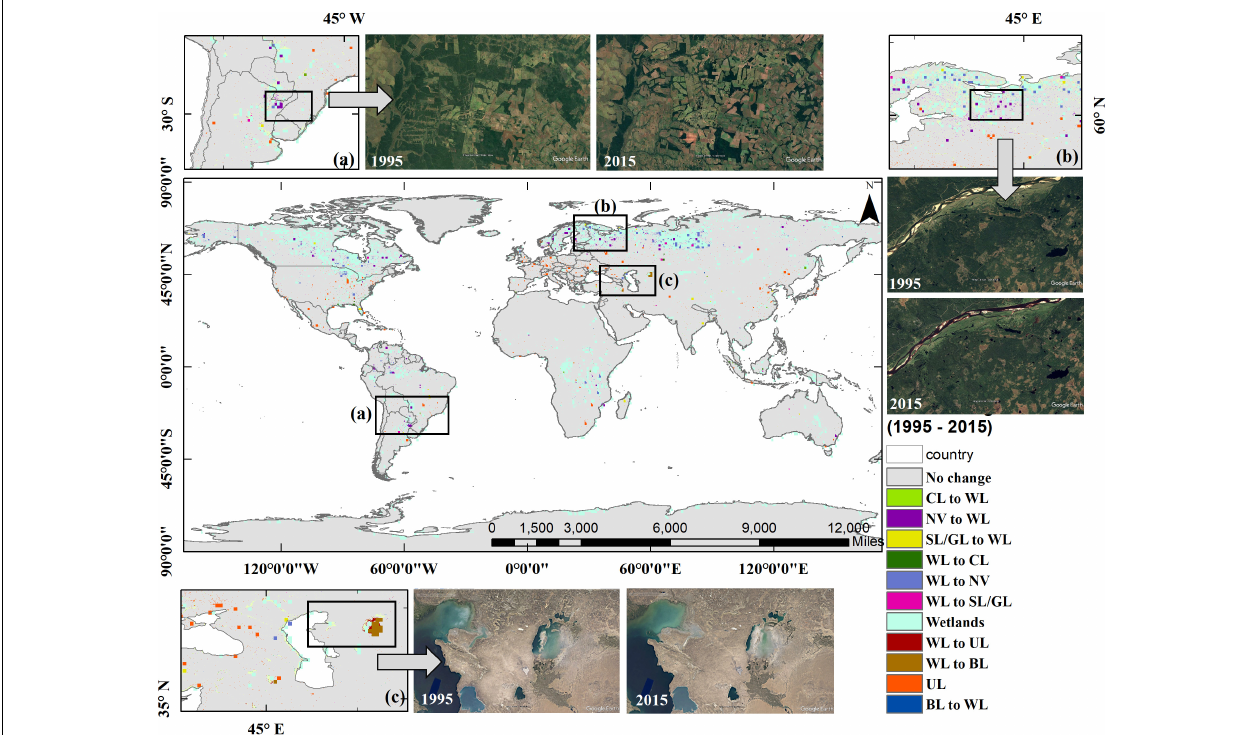
The correlation coefficient significance in Table 2 has been presented with ∗ as significant with p < 0.05 and ∗∗ as strongly significant with p < 0.01.